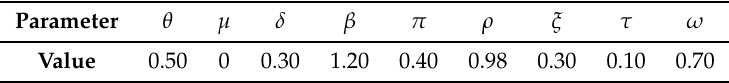
Table A4. Hyper parameters settings for the proposed Q-learning